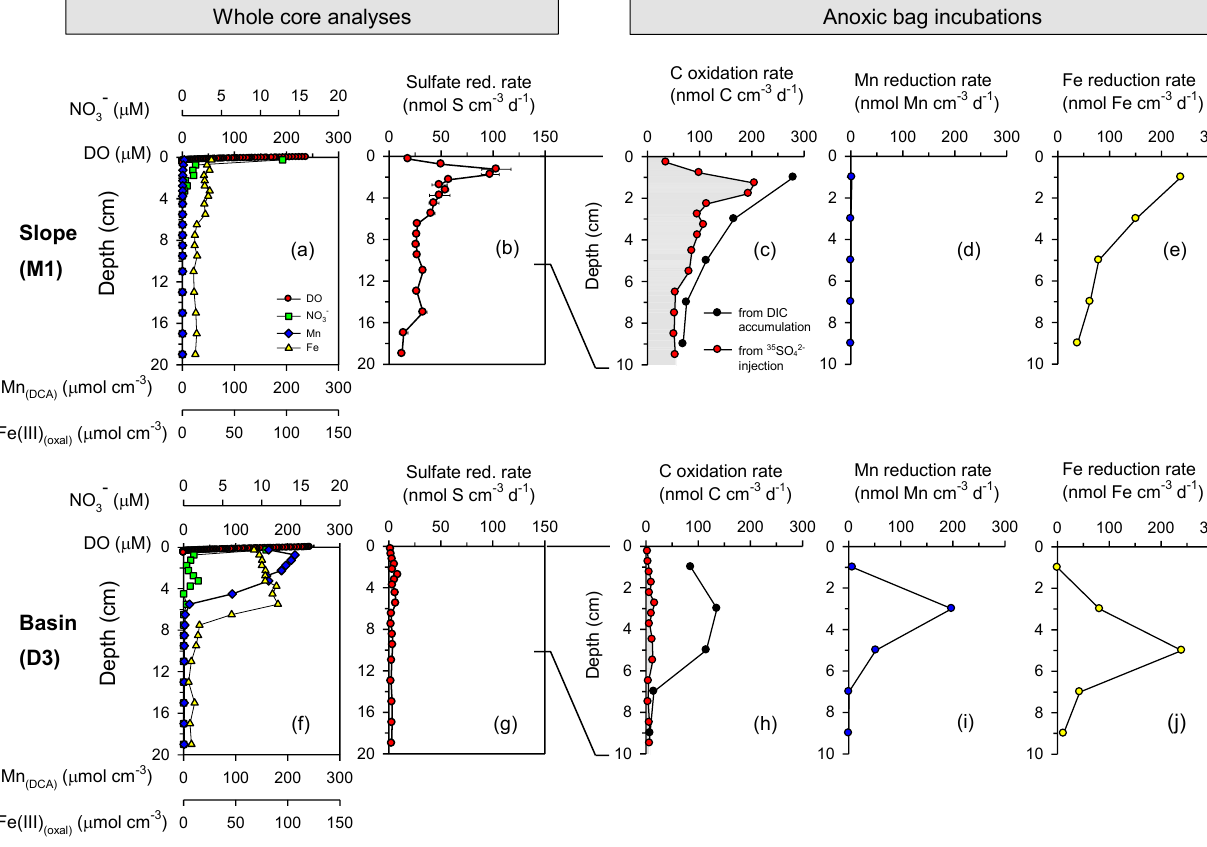
carbon equivalents, respectively (Table 4). At M1, within the 0–10 cm depth interval, the average ratio between total anaer- obic C org oxidation rate (10.7 mmol C m − 2 d − 1 ) and the C org oxidation from DIC production (14.0 mmol C m − 2 d − 1 )